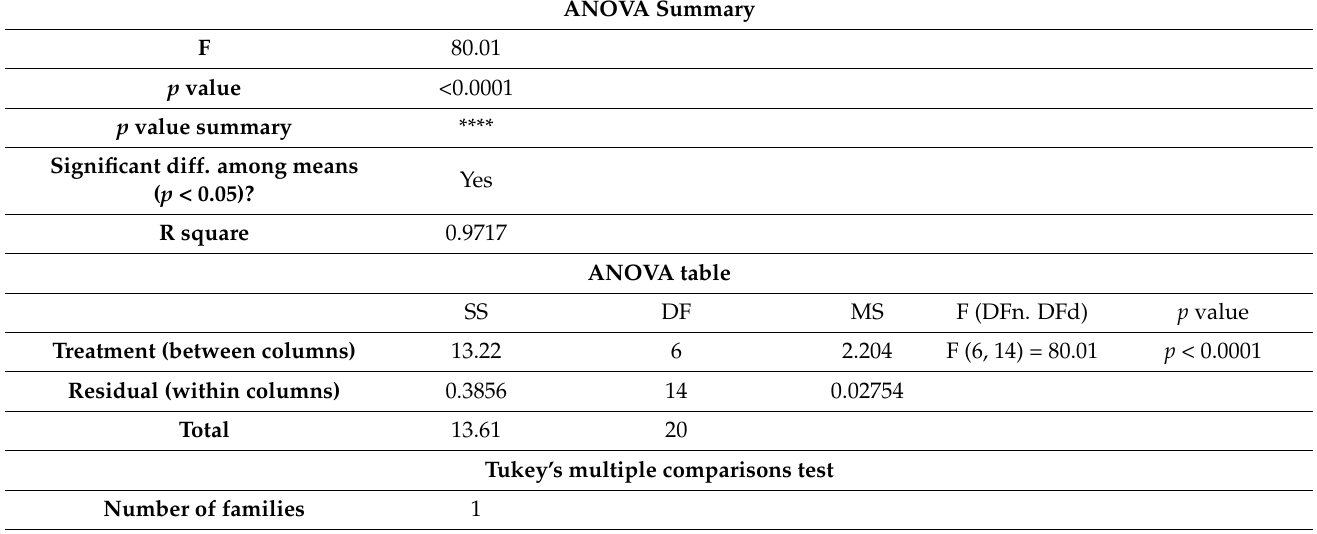
Table A8. One-way ANOVA analysis and Tukey’s multiple comparisons test to evaluate the effect of Turbidity on T/C. p > 0.0123 = not significant (ns); p < 0.033 = *; p < 0.0021 **; p < 0.0002 ***; p < 0.0001 =